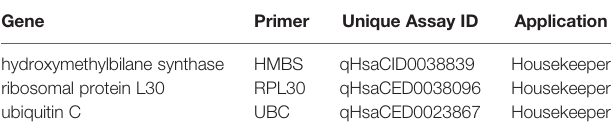
TABLE 2 | Primer for housekeeper